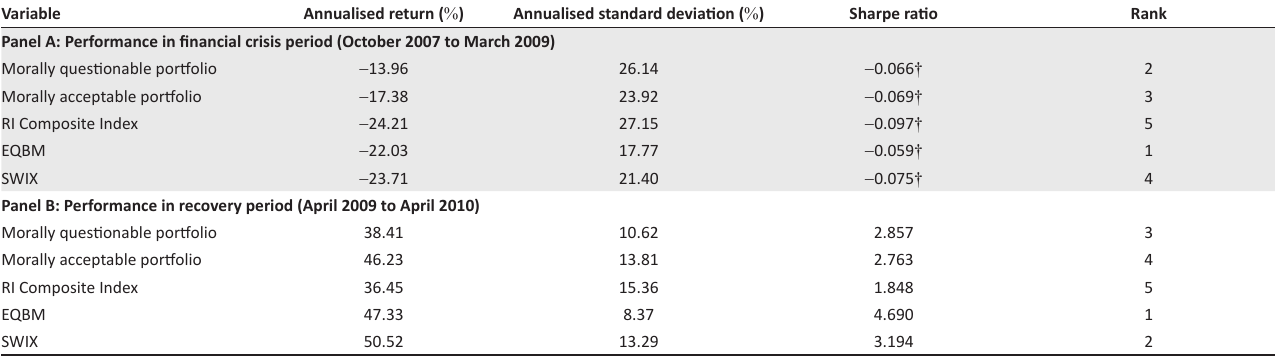
TABLE 6: Performance during different